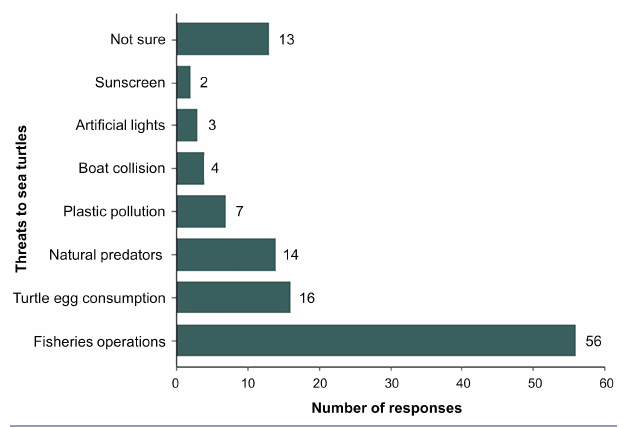
Fig. 5 . Respondent perceptions of the threats to sea